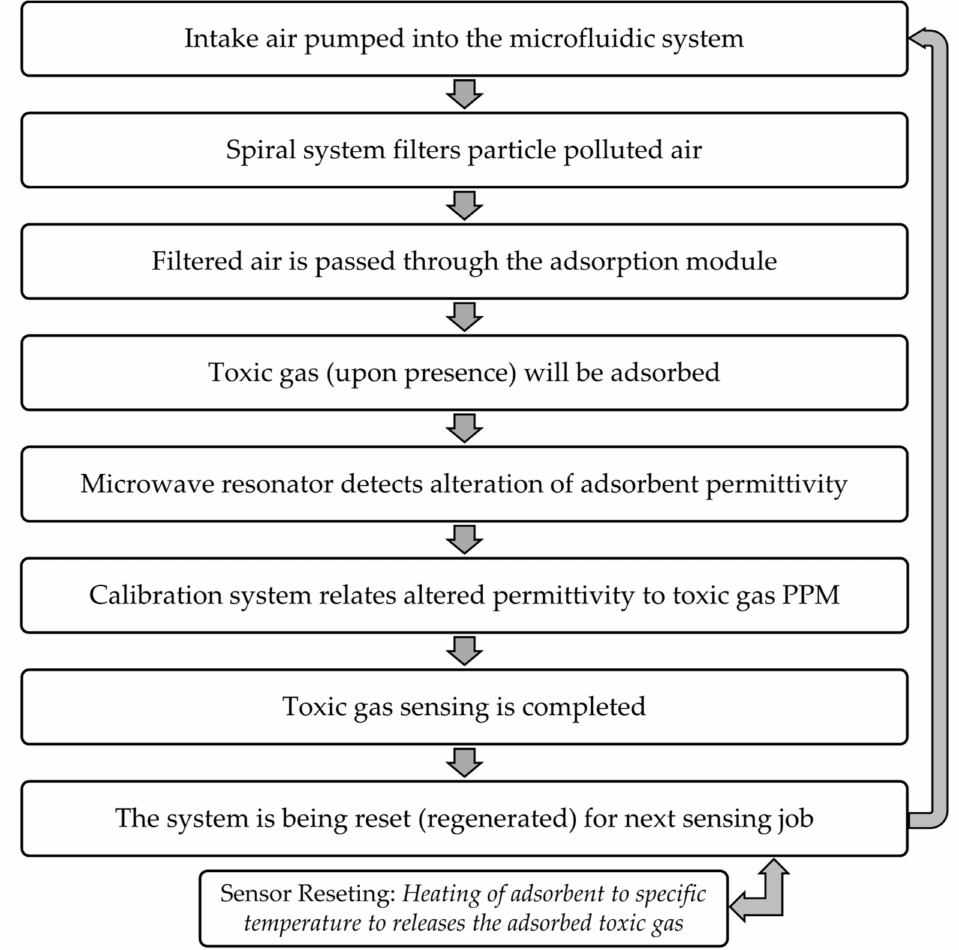
Figure 2. Sensor operation flowchart for detection of a toxic